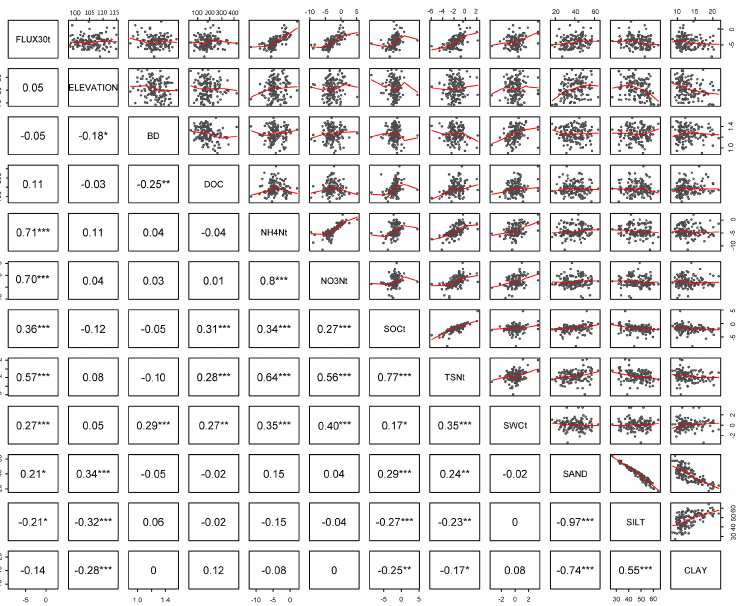
Figure 5. Correlation matrix with the Pearson’s correlation coefficients ( r ) of the N 2 O fluxes and the environmental factors. All of the variables in the correlation matrix are normally distributed. FLUX30 represents the N 2 O flux (gNha − 1 d − 1 ) ; ELEVATION is the elevation (m); and BD, DOC, NH4N, NO3N, SOC, TSN, SWC, SAND, SILT and CLAY are the soil bulk density (Mgm − 3 ) , soil dissolved